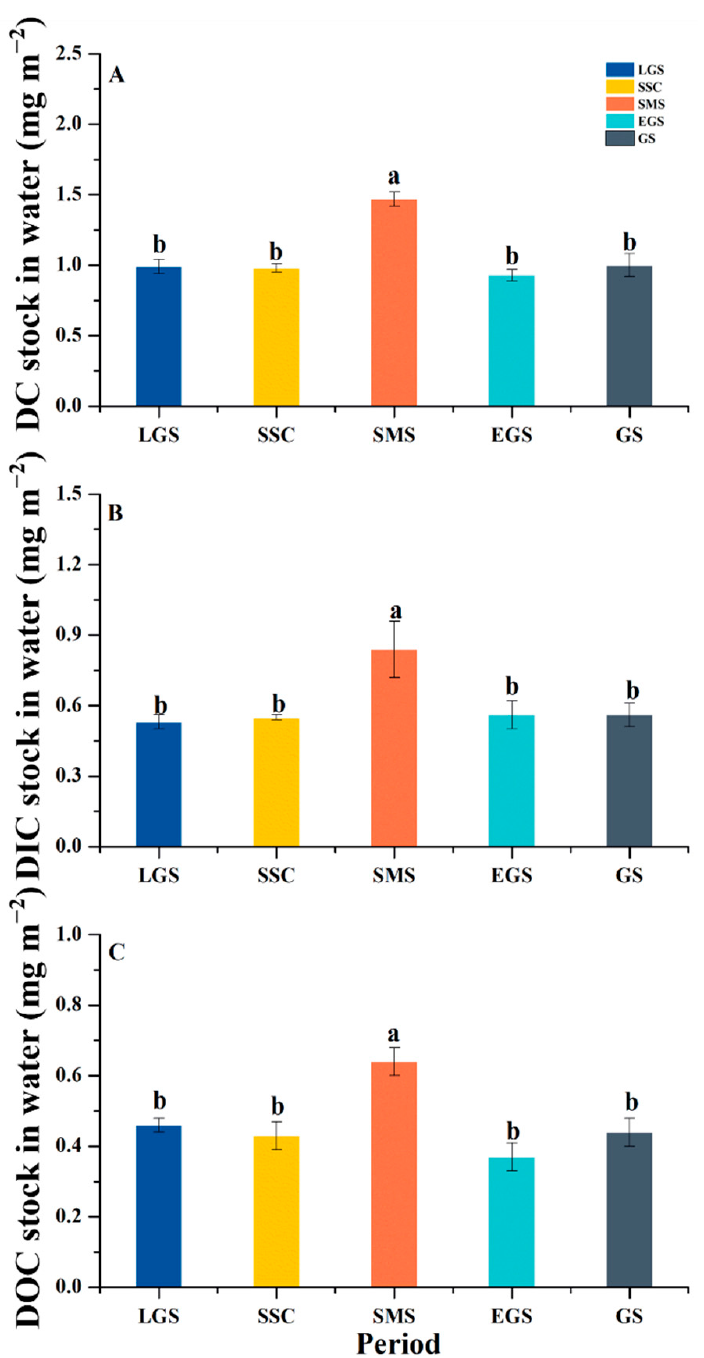
Figure 1. Dynamics of the dissolved carbon stock (DC), dissolved inorganic carbon stock (DIC), and dissolved organic carbon stock (DOC) in the subalpine forest streams in the upper reaches of the Yangtze River. Dissolved carbon stock (DC, ( A )); dissolved inorganic carbon stock (DIC, ( B )); dissolved organic carbon stock (DOC, ( C )). LGS, SSC, SMS, EGS, and GS indicate the sampling periods, i.e., the late growing season (LGS: September to October), seasonal snow cover (SSC: November to April of the following year), snowmelt season (SMS: April to May), early growing season (EGS: May to June), and growing season (GS: July to August). The values of the vertical coordinates are the average values from a total of 15 streams in this period, and the error bars are the standard deviations of 15 streams during every period. Different lowercase letters indicate significant differences among the different periods ( p < 0.05), while the same letter indicates no significant difference among each.